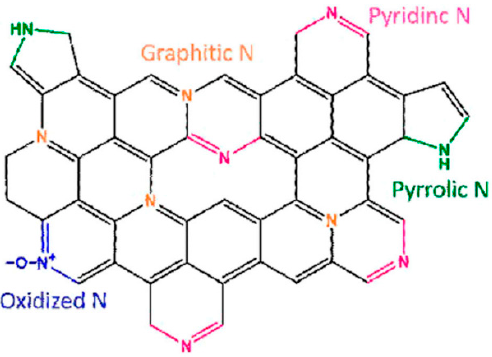
Figure 8. Four nitrogen doping configurations of a graphene molecule [23].